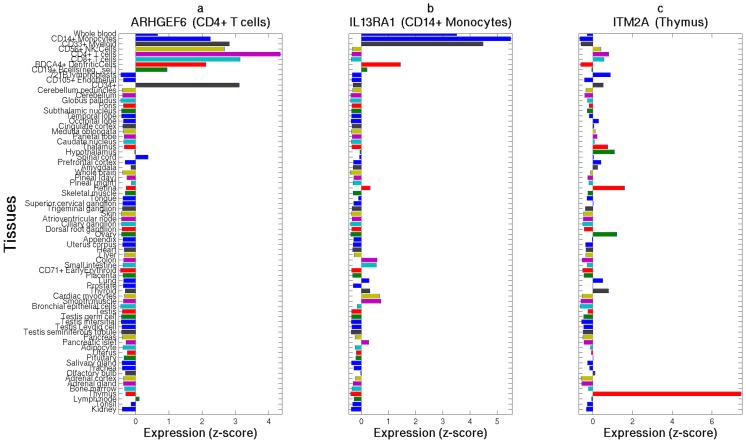
Three X-linked disease risk genes show high expression in immune-related tissues and cells.
ARHGEF6 (a), IL13RA1 (b), and ITM2A (c) show expression greater than 4 standard deviations above the average expression of these genes in T-cells (highest in CD4+ in purple), CD14+ monocytes (blue), and the thymus (red), respectively. Y-axis follows the respective tissues from Figure 2 and x-axis denotes a z-score for the deviation of expression in each tissue from the average expression of that gene. The title of each panel includes the name of the gene and the tissue with the highest expression for that gene.